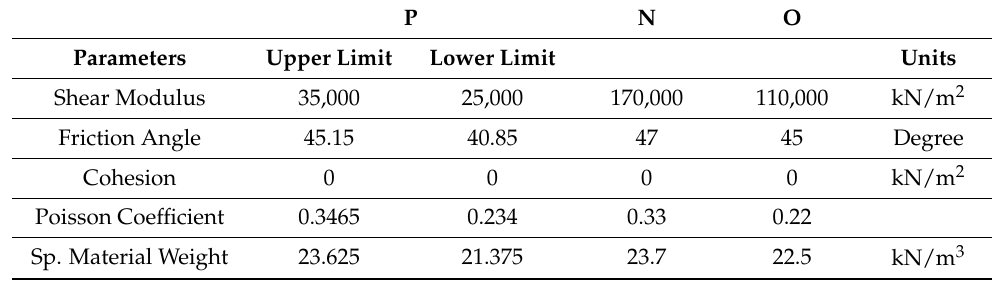
Table 1. Parameter values in different dam zones.